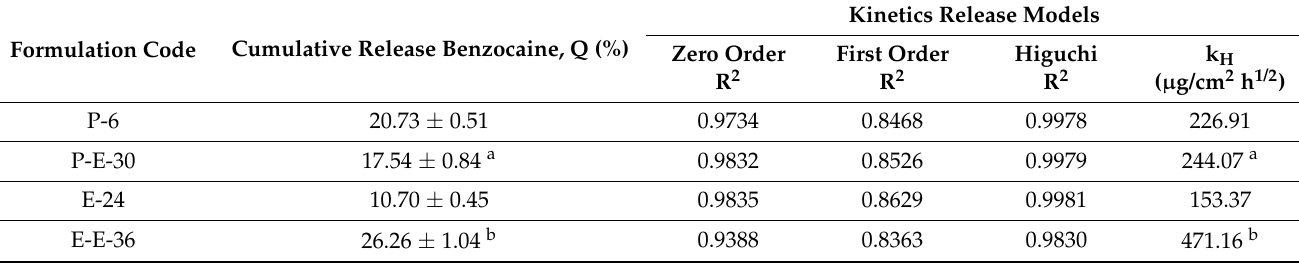
Table 6. Q factor, regression coefficient R 2 and fitting of mathematical models to the data of benzocaine release from selected